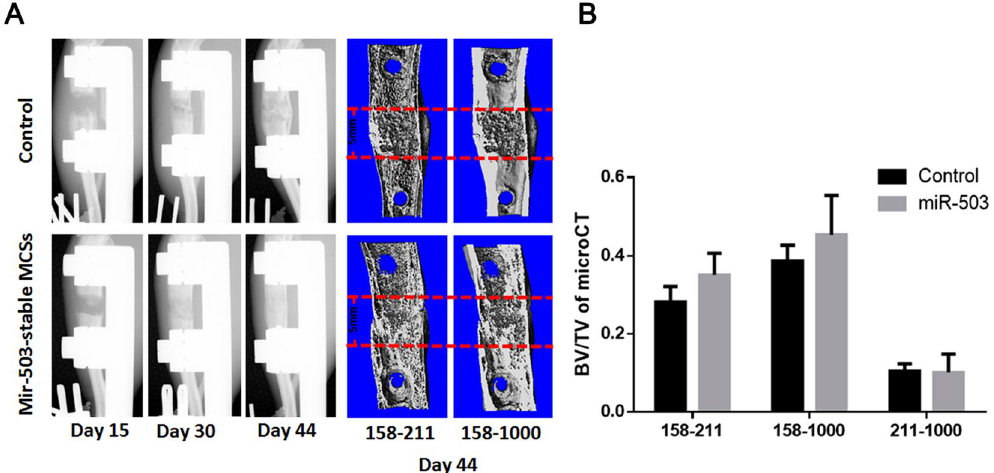
Figure 5. X-ray and microCT analysis confirm miR-503 overexpression therapy promote bone formation. ( A ) X-ray was examined at day 15, 30 and 44. Series of representative radiography were shown. The structure of the distracted bone had already repaired as normal at day 44 postoperation in miR-503 intervention group. A large amount of calluses around the distraction gap still could be found in control group. At 44 days postoperation, the central 150 layers bone tissues within the distraction gap were analyzed by microCT examination. (Vertical interval between red dotted lines represented the distraction gap). ( B ) Using microCT Quantitative analysis, result showed BV/TV was higher in miR-503 group between the thresholds 158 and 211. (n = 10 each group, * P <